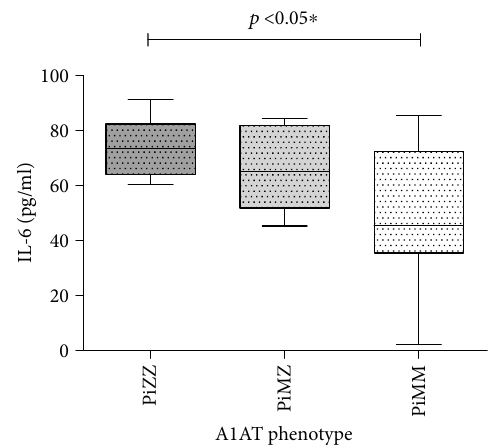
Figure 4: Comparison of IL-6 levels in COPD patients with PiZZ, PiMZ, and PiMM phenotypes of A1AT.